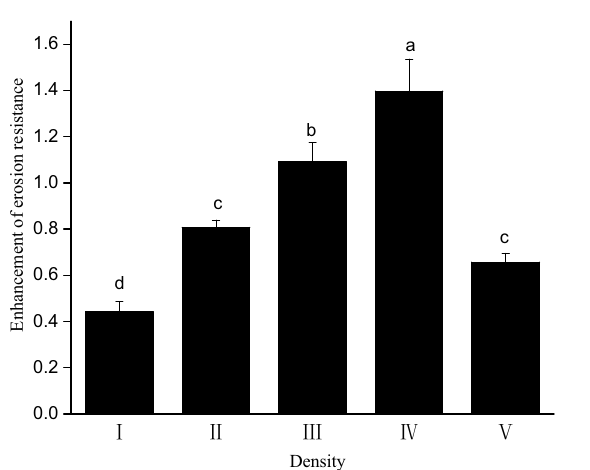
Figure 1. Stem and leaf water interception by E. nutans under different plant density treatments. Lowercase letters indicate statistically significant differences (p < 0.05) between different plant density treatments.